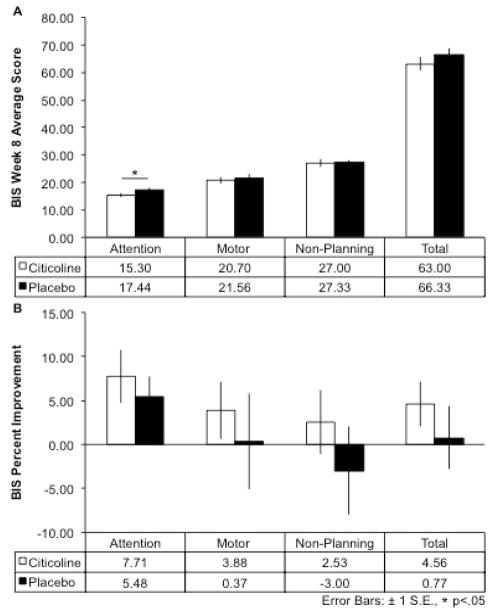
Barratt Impulsiveness Scale (BIS) Scores and Percent Improvement After 8-Week Citicoline TreatmentA.) After 8 weeks of treatment, the citicoline-treated group showed a significant reduction in attentional impulsivity compared to the placebo-treated group (t(17) = 2.20, p = .02, 1-tailed). B.) The citicoline-treated group showed greater percent improvement from baseline to week 8 for all BIS subscales as well as total BIS scores. Note: since lower scores are indicative of reduced impulsivity, percent improvement has been reciprocally plotted to aid visualization. Positive values indicate greater reduction of impulsivity.